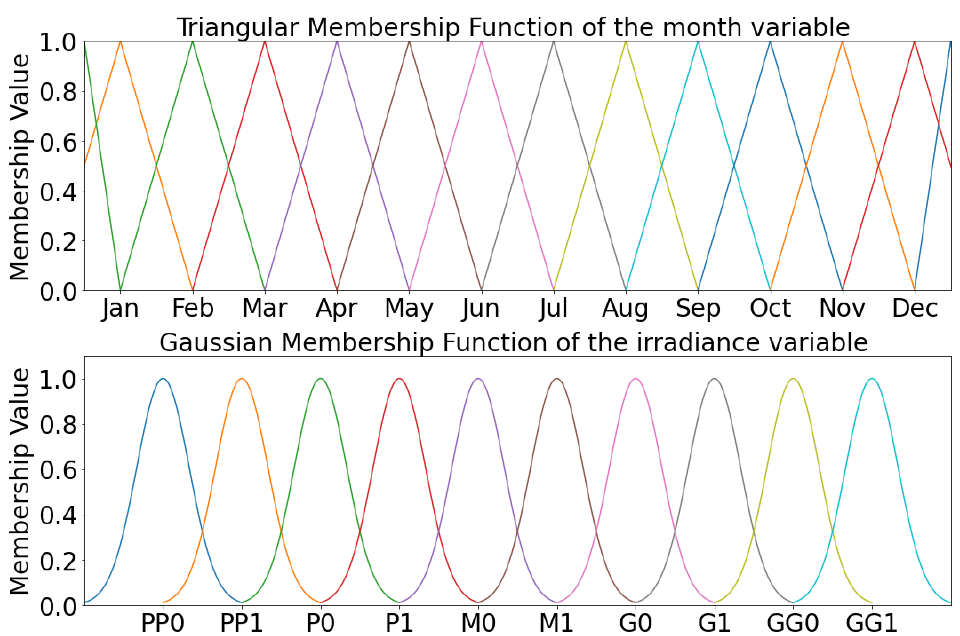
Figure 3. Example of the partitions with triangular and Gaussian membership function of the vari-